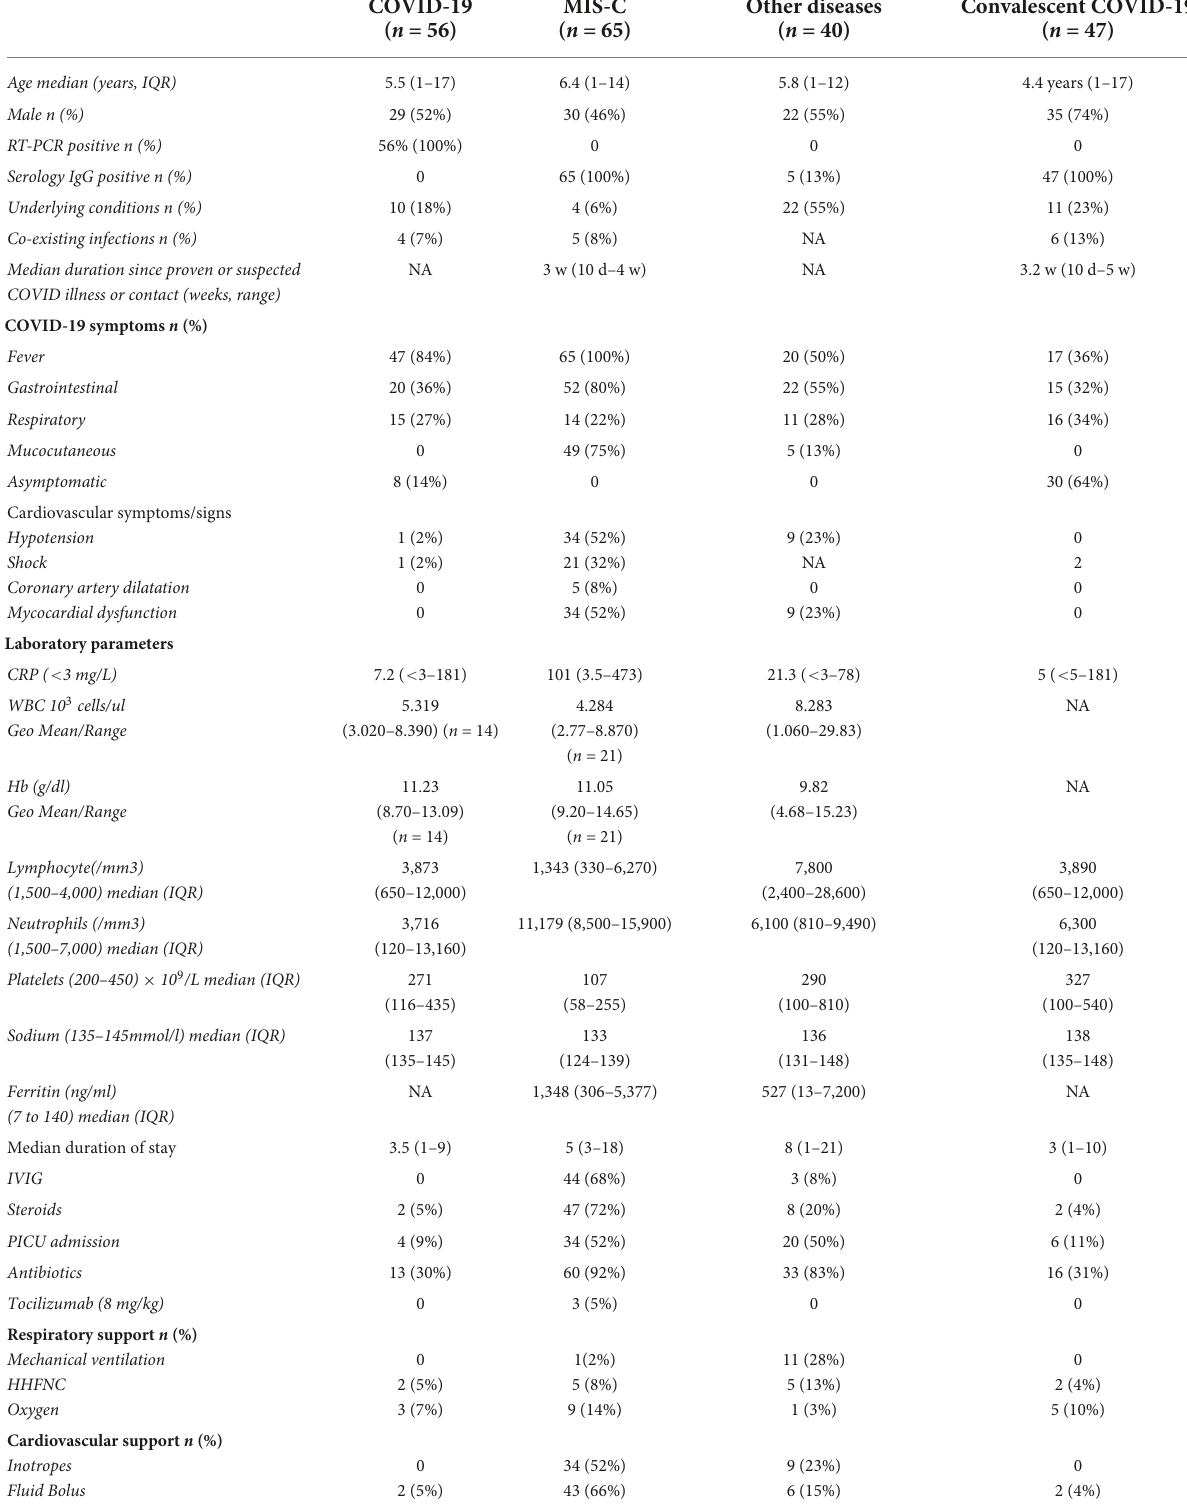
TABLE 1 Characteristics of study